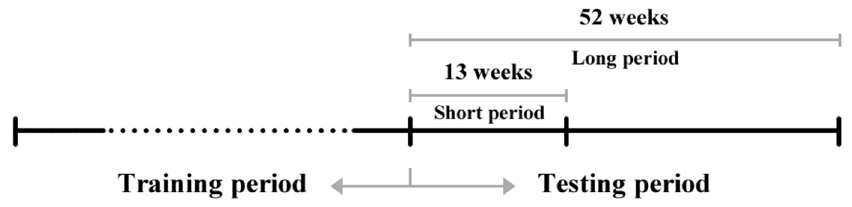
Figure 2. Data division for comparison. Source: Authors.